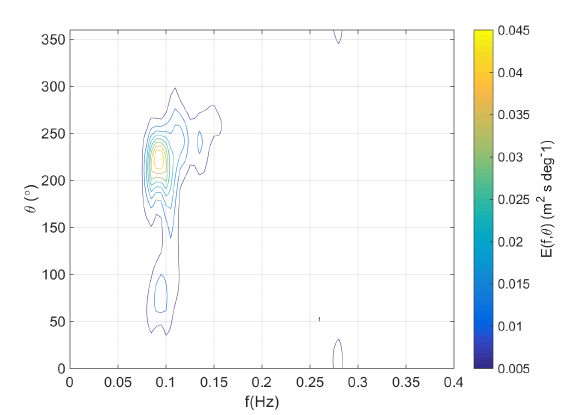
Figure 11. Directional wave spectrum for example given in Figure 10. Directional wave spectrum is estimated using a directional TRIAXYS wave rider